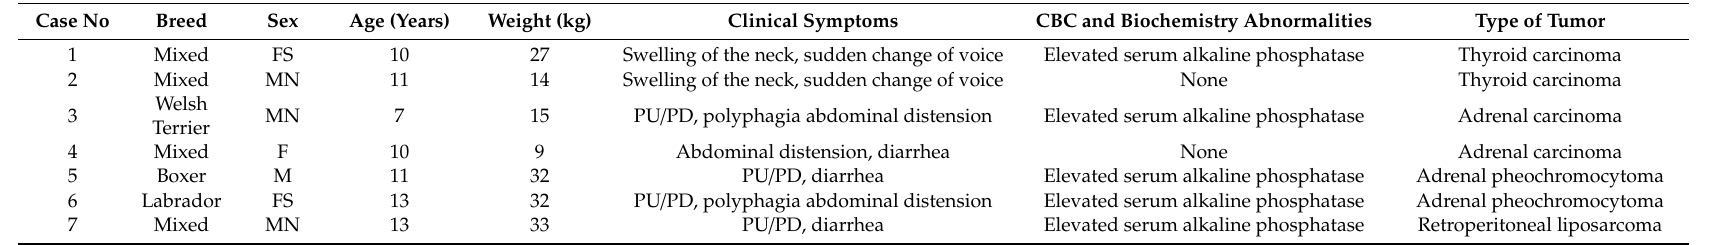
Table 1. Signalment and clinical signs of a population of dogs with neoplastic venous thrombosis.